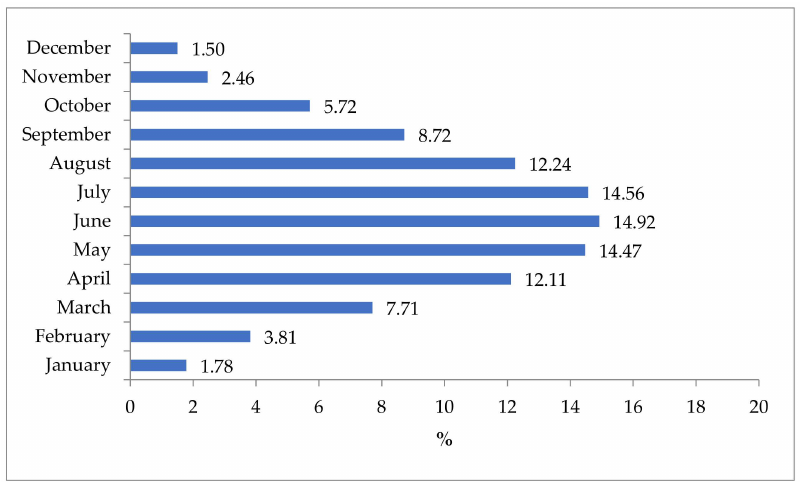
Figure 8. Electricity production share considering customer’s preferences and technical data of the building in particular months,